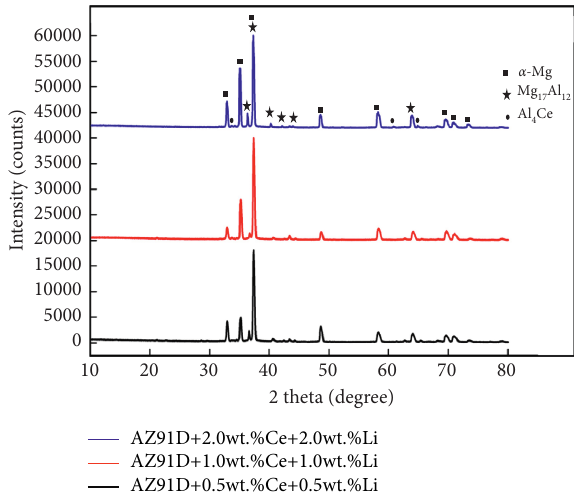
Figure 5: XRD Analysis of AZ91D+ X wt.% Ce+X wt.% Li.